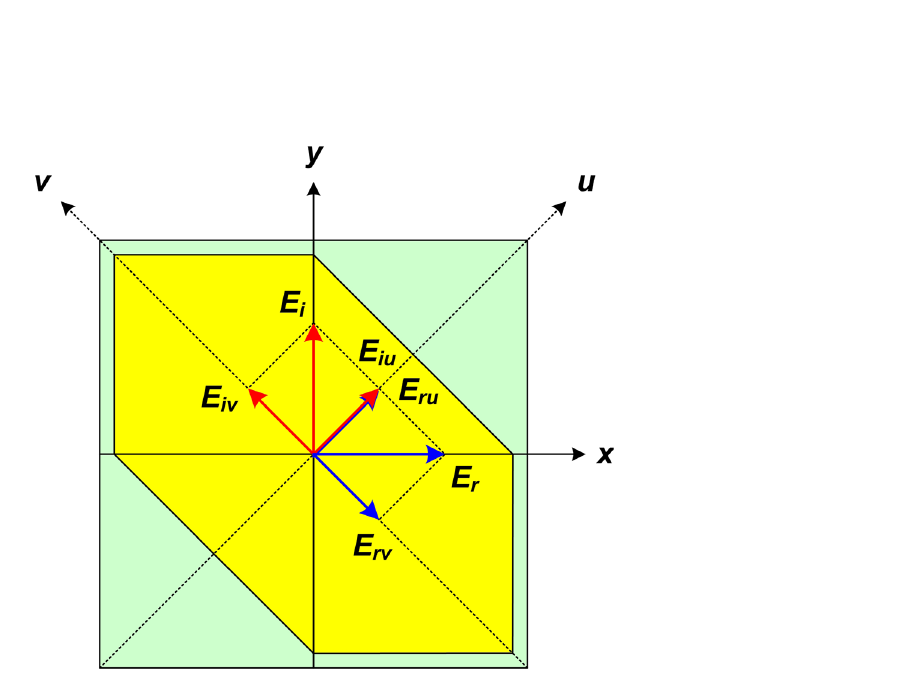
Figure 5. Working principle of the polarization